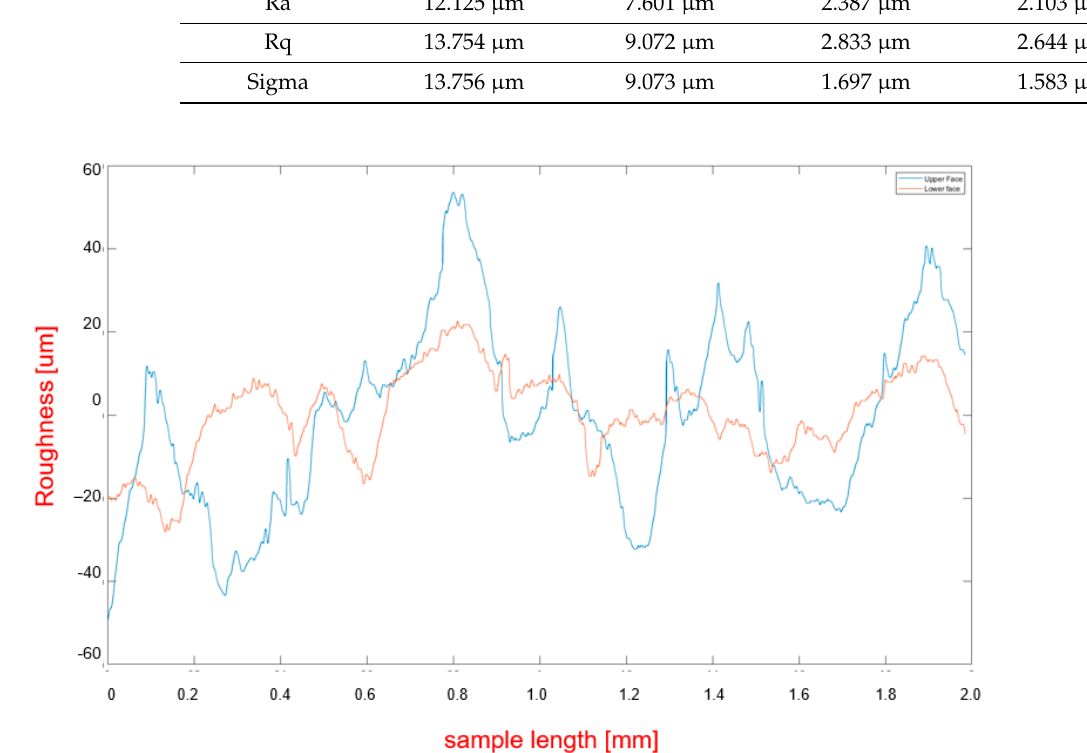
Figure 6. Profile analysis of upper and lower faces.